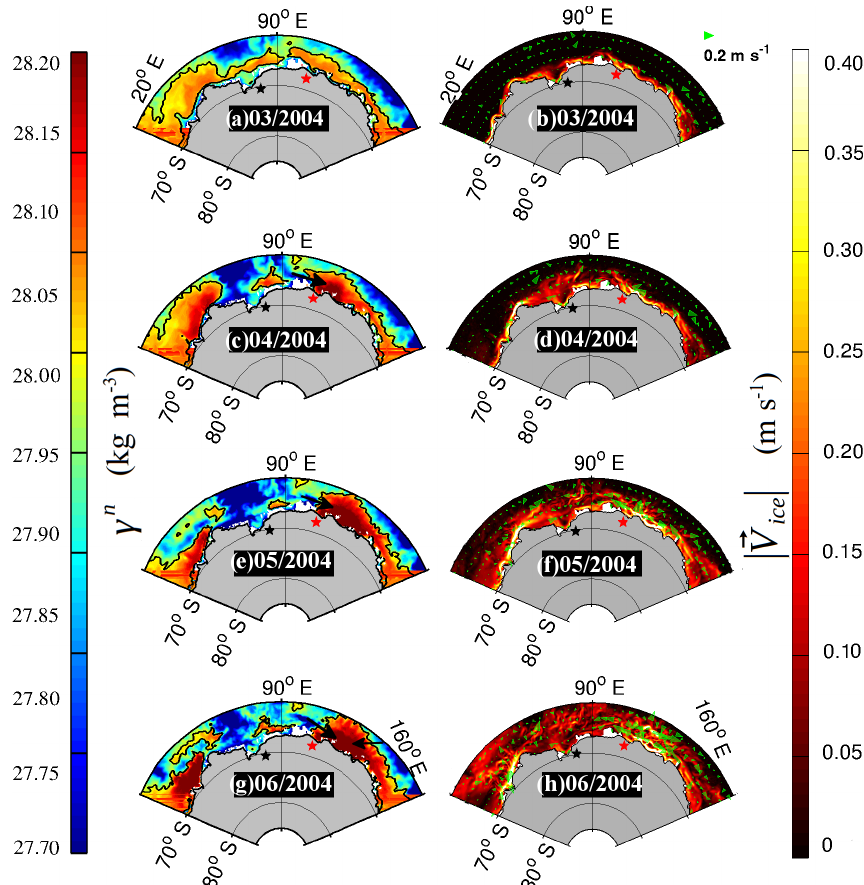
Figure 13. UR025.4 neutral densities filled contours at 250m depth in the center of the UCDW entrainment in the Indian Ocean sector and the Western Pacific sector in March (a) , April (c) , May (e) and June (f) of 2004. The black lines mark the 28kgm − 3 neutral density values that separate UCDW from LCDW. The black arrow represents the direction of the density gradient. Maps (b) , (d) , (f) and (h) show the sea ice speed module (ms − 1 ) for the same months as the neutral density contours. The green arrows show the current speed at 250m, which is the same depth as the neutral density contours. The black ( (cid:63) ) and red stars on all maps represent the locations of Prydz Bay and Vincennes Bay,